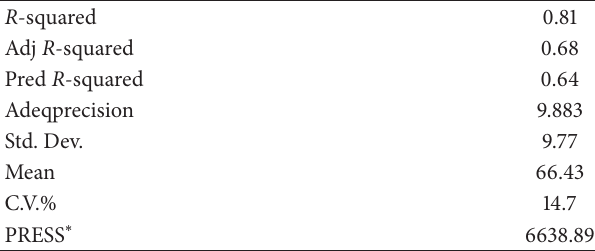
∗ Predicted residual sum of squares of